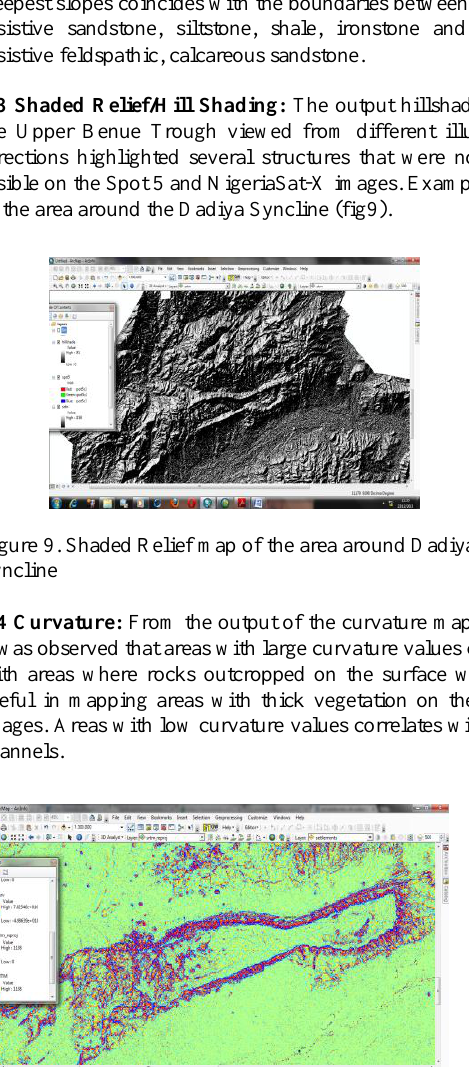
3.5 Stream Network/stream order/stream to feature: The stream network of the Upper Benue Trough generated from the stream direction grid and stream accumulation grid were the same as observed on the satellite images. The stream order generated based on the Strahler method generated produced the drainage map of the study area (fig 11) which is useful in mapping out lineaments since straight stream channels are most likely to be along fracture zones. 3.6 3D visualisation: The 3D view of the DEM (Fig 12) displayed patterns that were not visible in 2D.